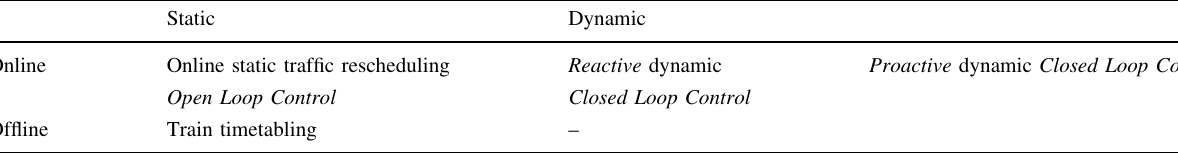
Table 3 Online versus offline and static versus dynamic approaches